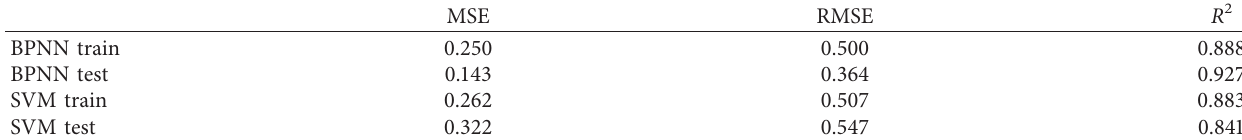
Table 6: Evaluation parameters of machine learning methods.